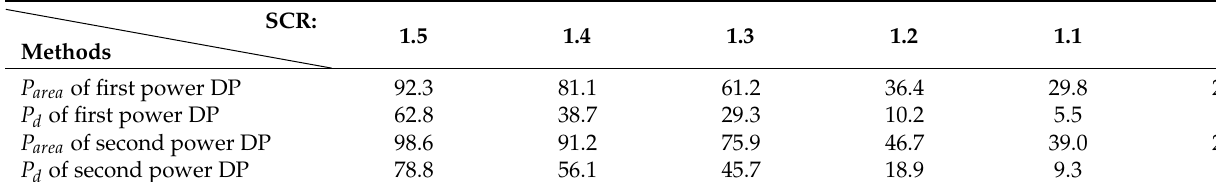
Table 2. Performance of the proposed DP with different SCRs.